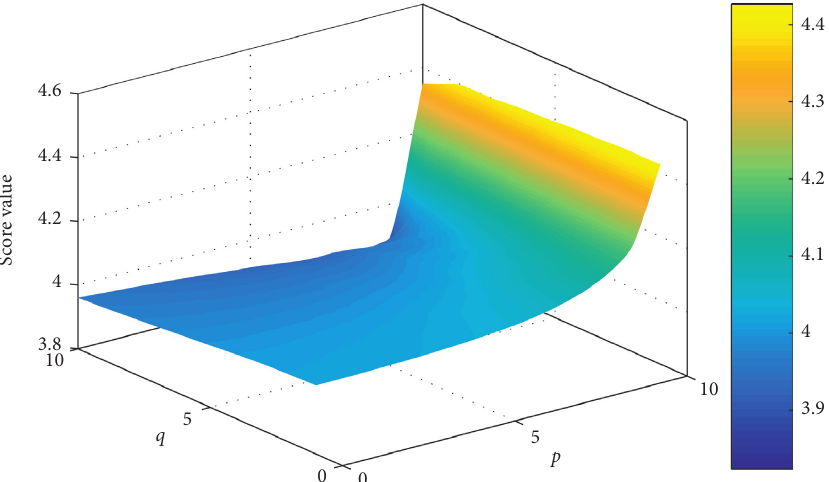
Figure 4: Scores of A